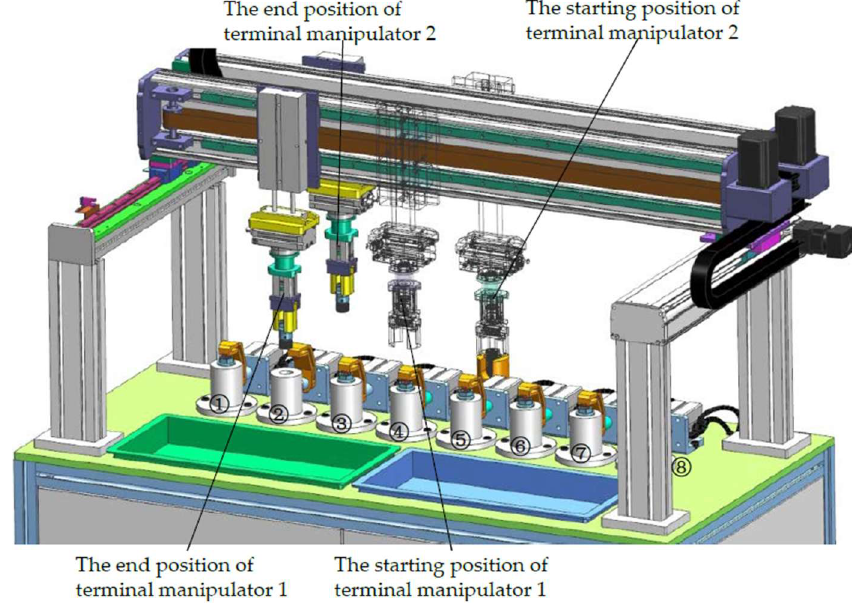
Figure 10. Sketch map of sorting action 1.